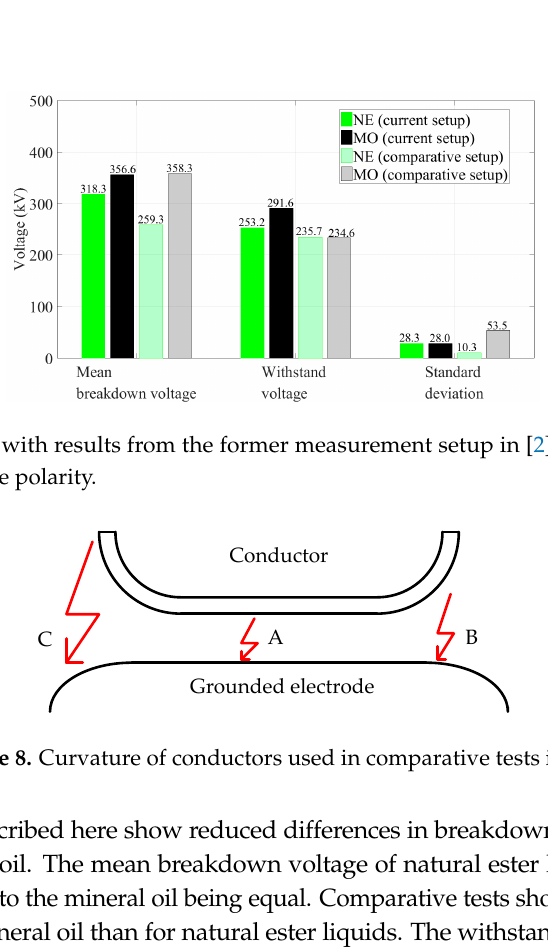
7 of 13 Table 3. Breakdown results for conductor test at positive polarity, Weibull distribution fitting. Liquid